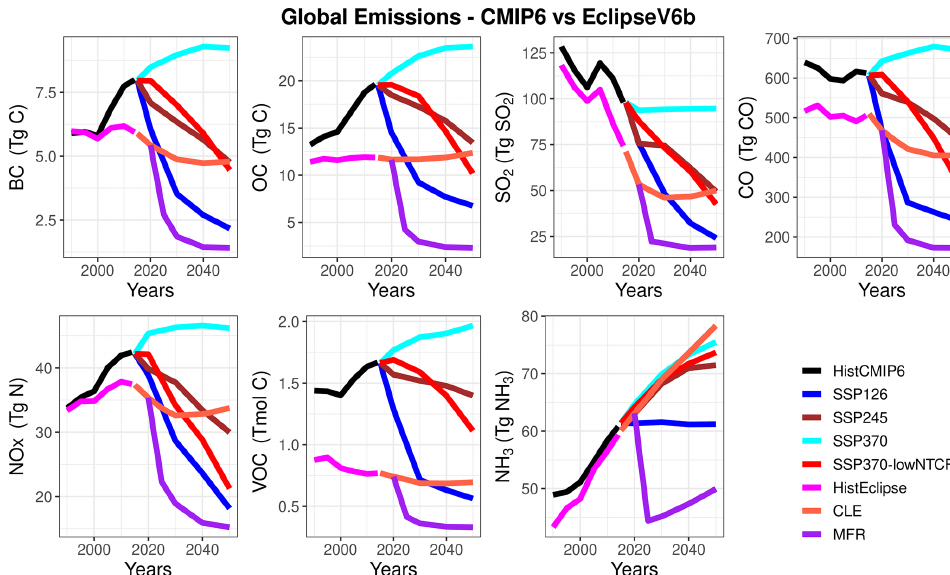
Figure 1. Global recent past and future CMIP6 and Eclipse V6b anthropogenic emissions for different pollutants and scenarios. Table 1. GISS-E2.1 simulations carried out in the Eclipse and CMIP6 ensembles.